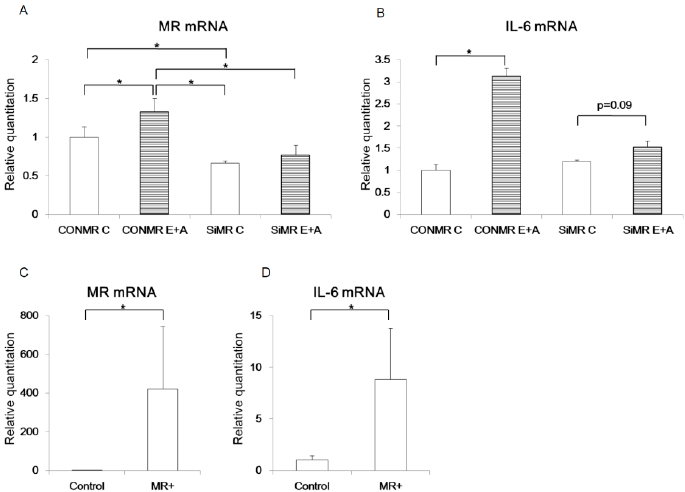
Figure 4. MR regulates IL-6 mRNA expression in pancreatic islet cells. MR mRNA (A) or IL-6 mRNA (B) were measured in α TC cells (p9) transfected with control siRNA (CONMR) or siRNA targeting MR (SiMR) and treated by vehicle (Control, C) or eplerenone and aldosterone (E+A) ( n = 4). MR mRNA (C) and IL-6 mRNA (D) were measured in the 1C3 IKEI pancreatic cells (IKEI cells) ( p = 3) transfected with empty vector (Control) or human MR-expressing vector (MR+) ( n = 4). * p < 0.05. Data are shown as mean ± SE.